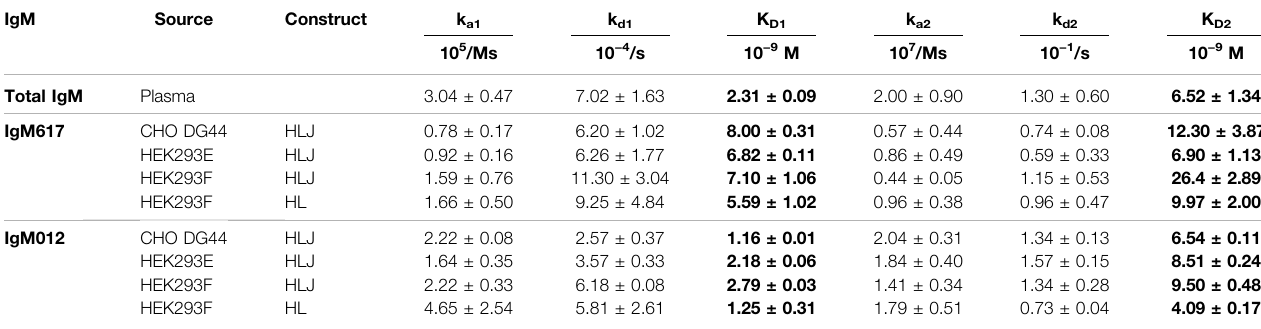
TABLE 2| Kinetic andaf fi nityconstants ofC1qbindingtodifferentpuri fi edrecombinantIgMsexpressed inmammalianexpressionsystems.Valuesareobtainedafterglobal fi ttingofthebindingsignals ( Figure5 )and averagingfromreplicates(2 – 4).Af fi nityconstants(K D1 and K D2 ) areobtained fromtheratiobetweenkineticsparameters (k d1 / k a1 and k d2 /k a2 ). Standard errors are obtained as standard deviation between